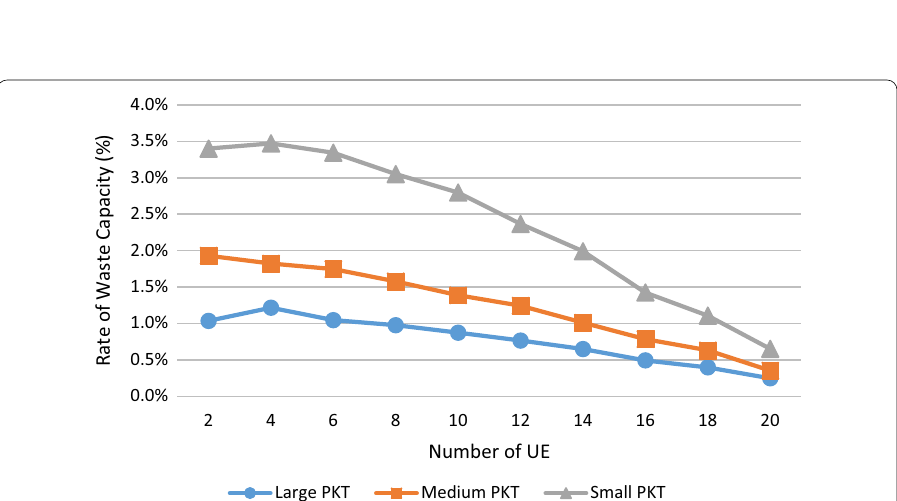
Fig. 17 Analysis of waste capacity rate in different packet size situations; The performance analysis of waste capacity rate in different packet sizes for our proposed EURA